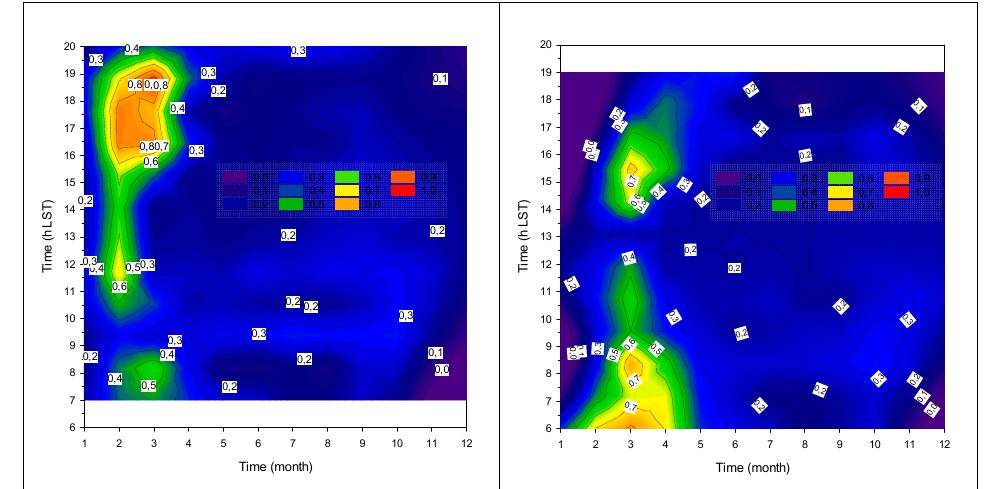
Figure 5. Month–hour diagrams of the T UM values in TATY under all-sky conditions in climatic zone A: first raw, Irakleio (left), Kalamata (right); climatic zone B: second raw, Agrinio (left), Lesvos (right); climatic zone C: third raw, Alexandroupoli (left), Tripoli (right); climatic zone D: fourth raw: Kastoria (left), Serres (right). The color code refers to the T UM levels, which have been kept in the range 0 < T UM